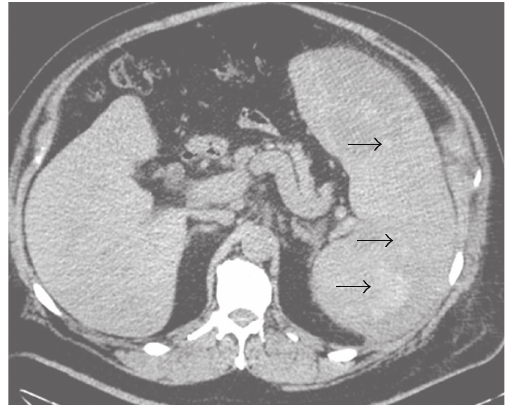
Figure 1: Axial noncontrast CT section through the abdomen showing splenomegaly with multiple hyperdense nodules in the splenic parenchyma (arrowheads).